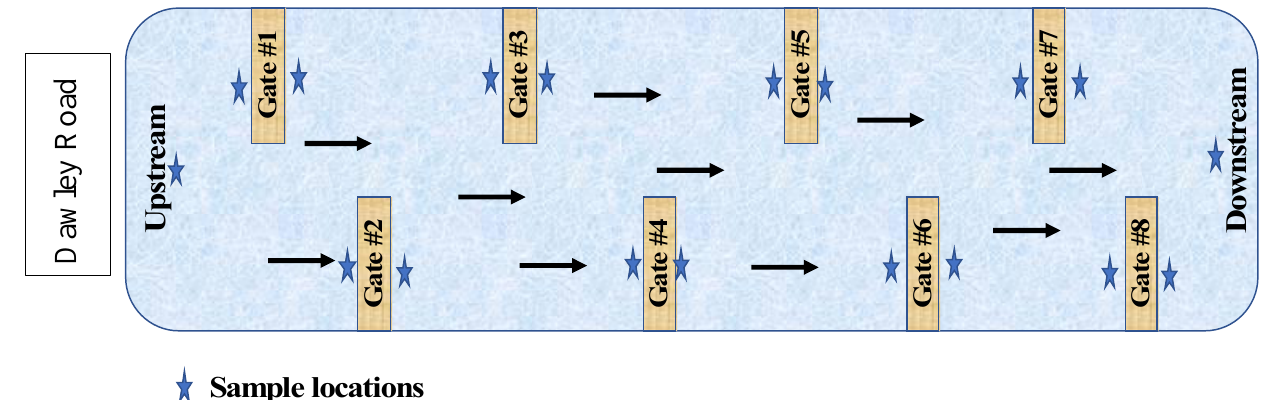
Figure 2. Simplified representation of gate locations and sample collections in Eckert’s Ditch.